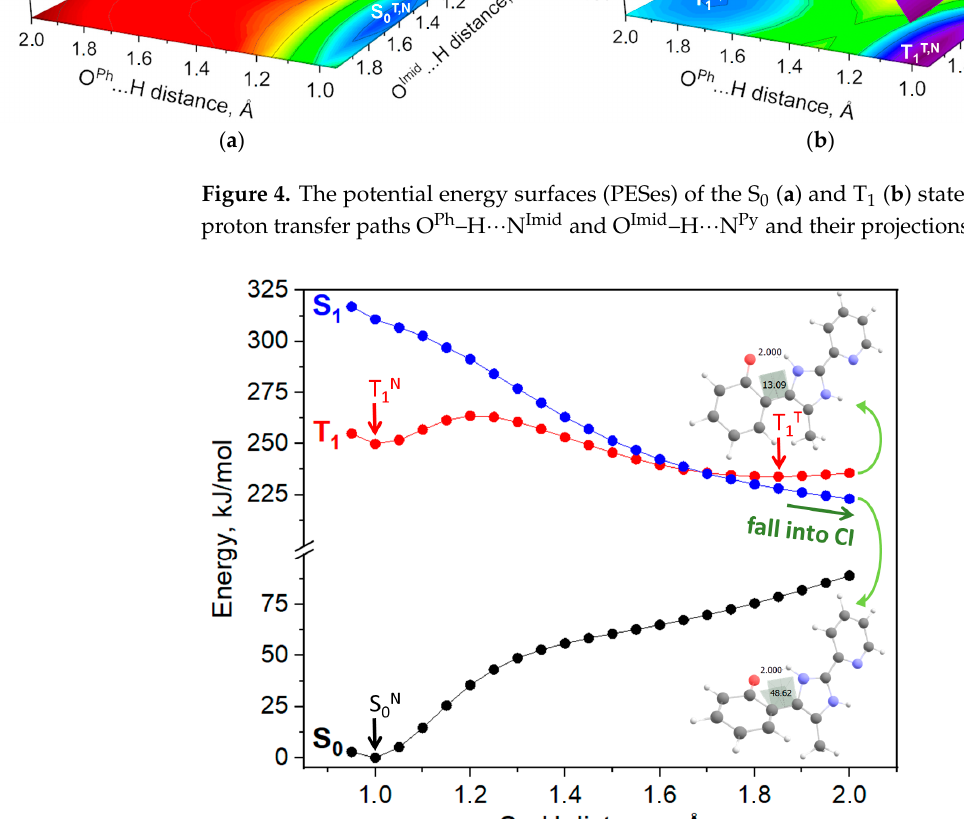
Figure 5. The potential energy curves (PECs) of the S 0 , S 1 and T 1 (right) states of L H,OH along the proton transfer path O Ph –H···N Imid . The arrows show the energy minima on these PECs. The opti- mized geometries of the T 1 and S 1 states with the O Ph –H distance of 2.0 Å are also depicted. 2.5. Excitation and Emission Properties of L H,OH and L OH,OH L H,OH and L OH,OH are non-luminescent in MeCN solution, indicating the possible predominance of various non-radiative deactivation pathways. In the solid state, L H,OH emits in the light green region (Figures 6 and 7). The broad unstructured luminescence band of L H,OH is located in the region 400–750 nm with a maximum at 546 nm. λ det = 540 nm), so the observed emission is associated with phosphorescence, i.e., with a